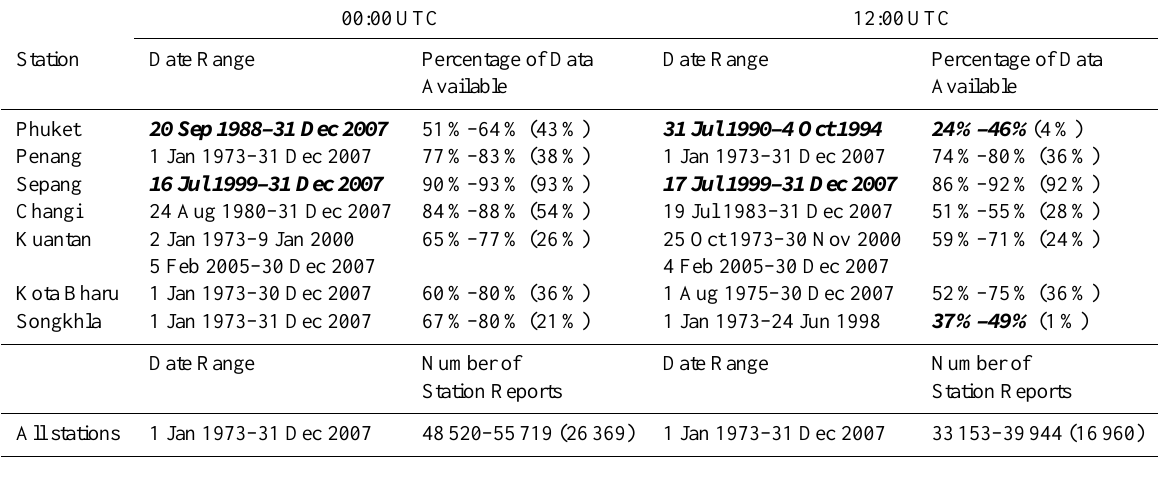
Table 1. Table shows the period for which radiosonde wind data were available at 00:00UTC and at 12:00UTC with the precise start and end dates in the column Date Range. (Note that data from Kuantan came in two periods.) Within each period, the proportion of days for which data were actually available lies within the shown percentage range for all pressure levels used in this study, except 925mb which was instituted as a mandatory level only in the 1990s and so the lower percentage at this level is shown in parentheses. The total period spanned and the number of station reports per level are given in the last line. Data periods less than twenty years or data availability less than 50% (excluding 925mb) are highlighted in bold italics.